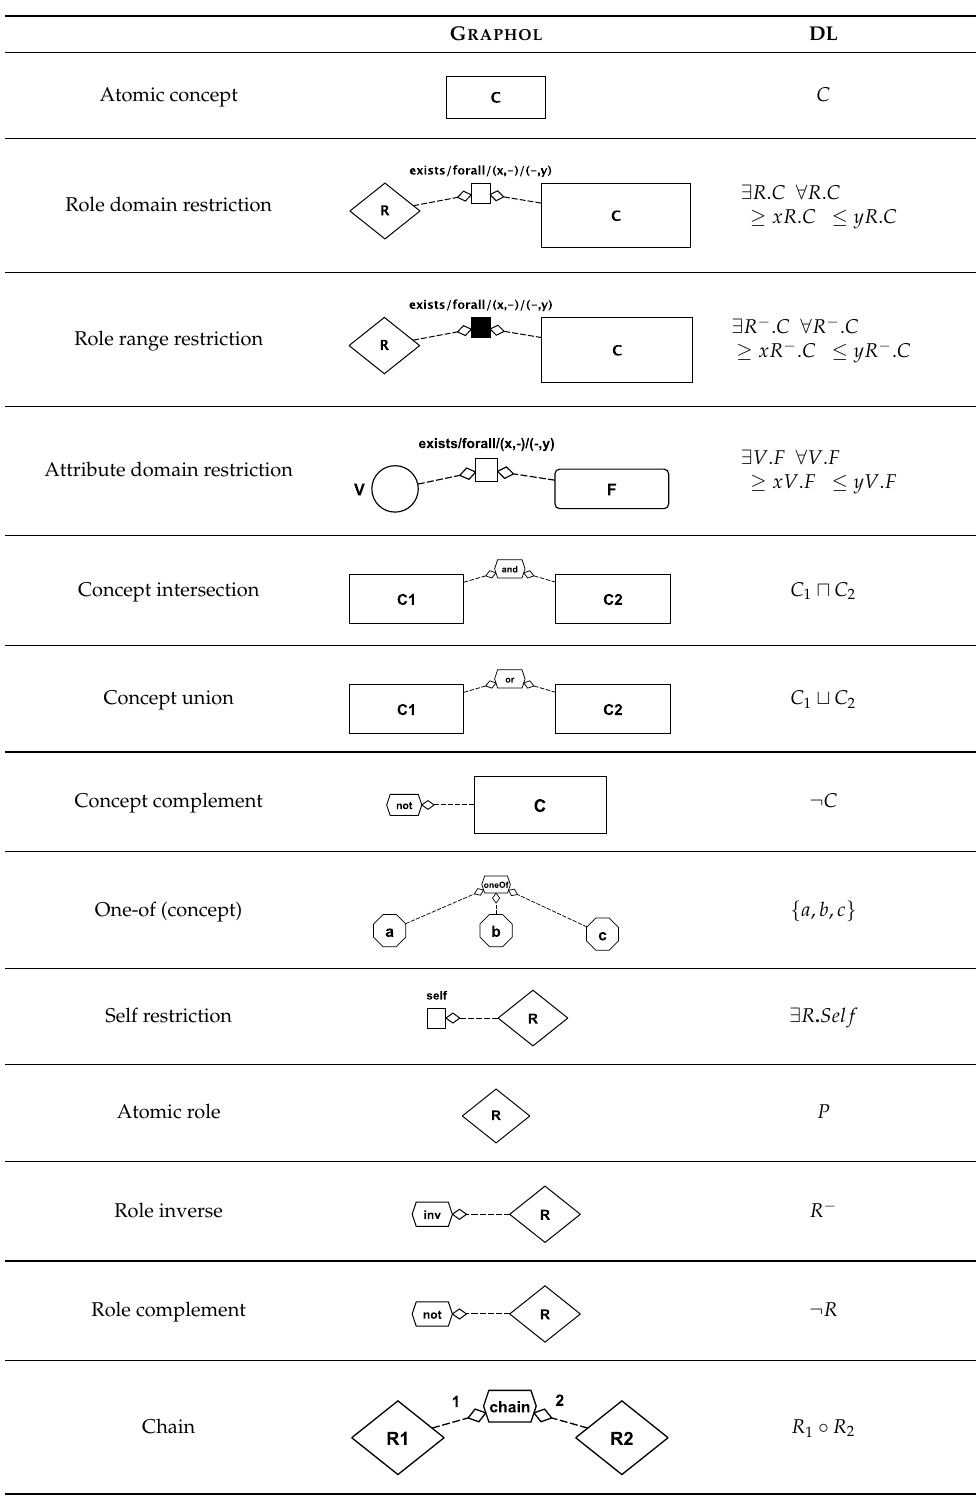
Table 2. Correspondence between G RAPHOL and DL for concept and role expressions of depth 0 or 1. C , C 1 , and C 2 denote atomic concepts, and R , R 1 , and R 2 denote atomic